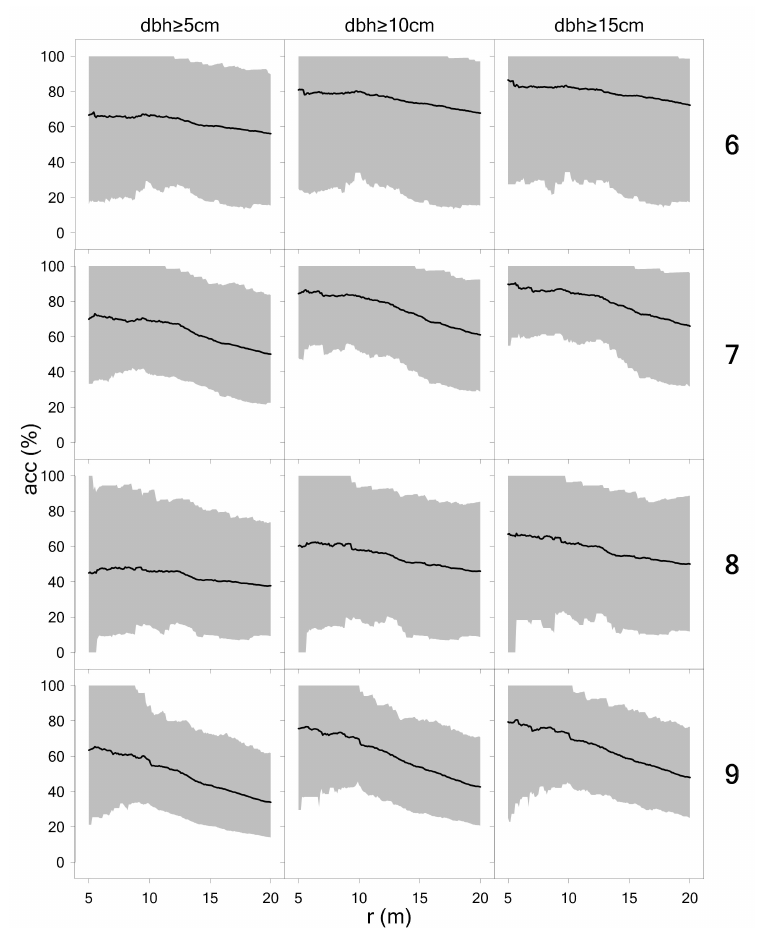
Figure A6. Overall accuracy over plot radius. Bold black line indicates mean. Gray area indicates 95% confidence envelope. Bold numbers on the right mark scan variant.